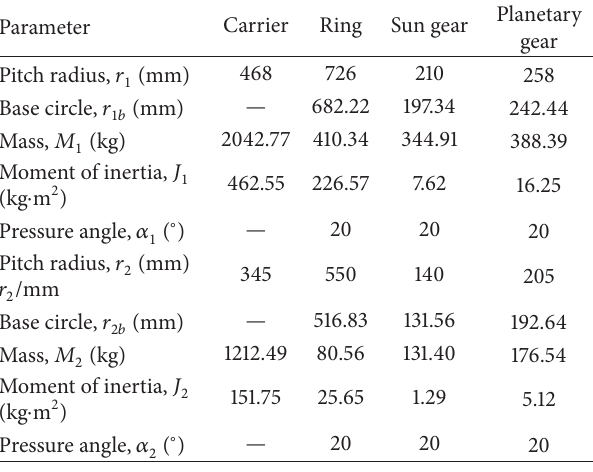
Table 1: Primary parameters of planetary gear train.